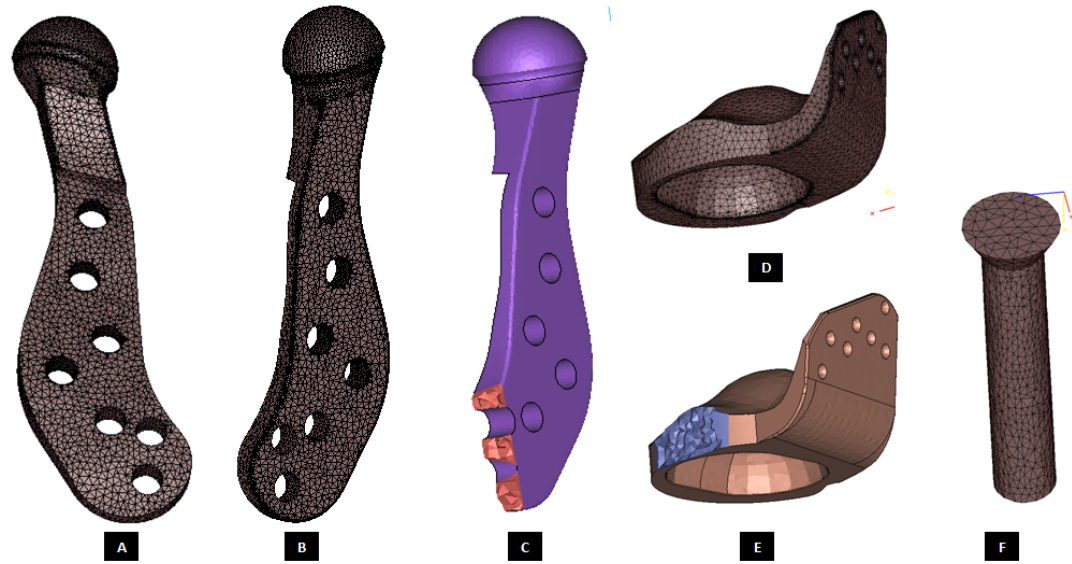
Figure 27. Three-D finite element mesh of the components of patient-specific total TMJ prostheses. ( A – C ) Show FE mesh of the condylar/ramal component of the ‘simple’ TMJ implant (without notches). ( D , E ) Show FE mesh of the fossa component, and ( F ) demonstrates FE mesh of a screw for device fixation.